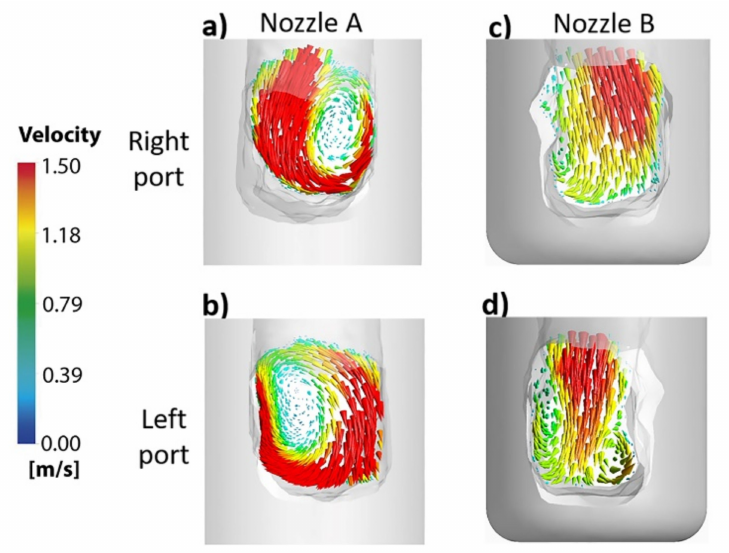
Figure 26. Flow through the ports of the nozzles with clogging. ( a ) Nozzle A, right port. ( b ) Nozzle A, left port. ( c ) Nozzle B, right port. ( d ) Nozzle B, left